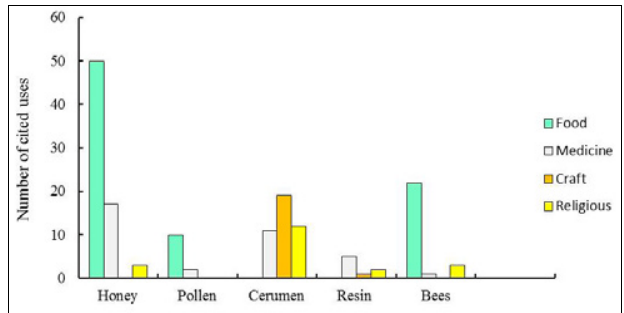
Fig 2 . A summary of literature reports of the main uses given to stingless bee products by different indigenous groups of tropical